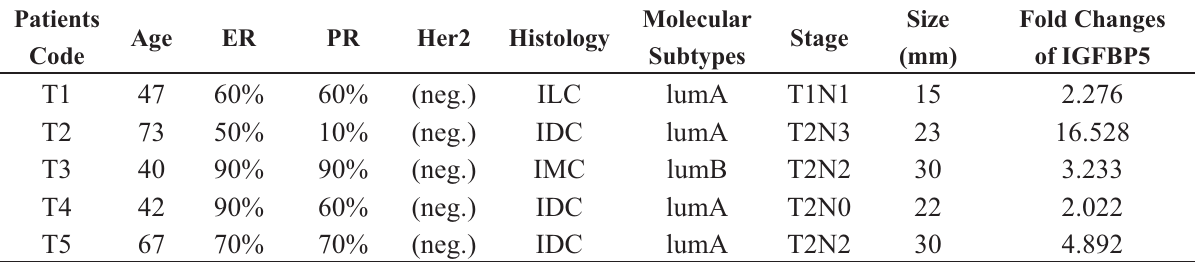
Table 2 Tumor characteristics and fold changes of IGFBP5 expression in patients for use in microarray